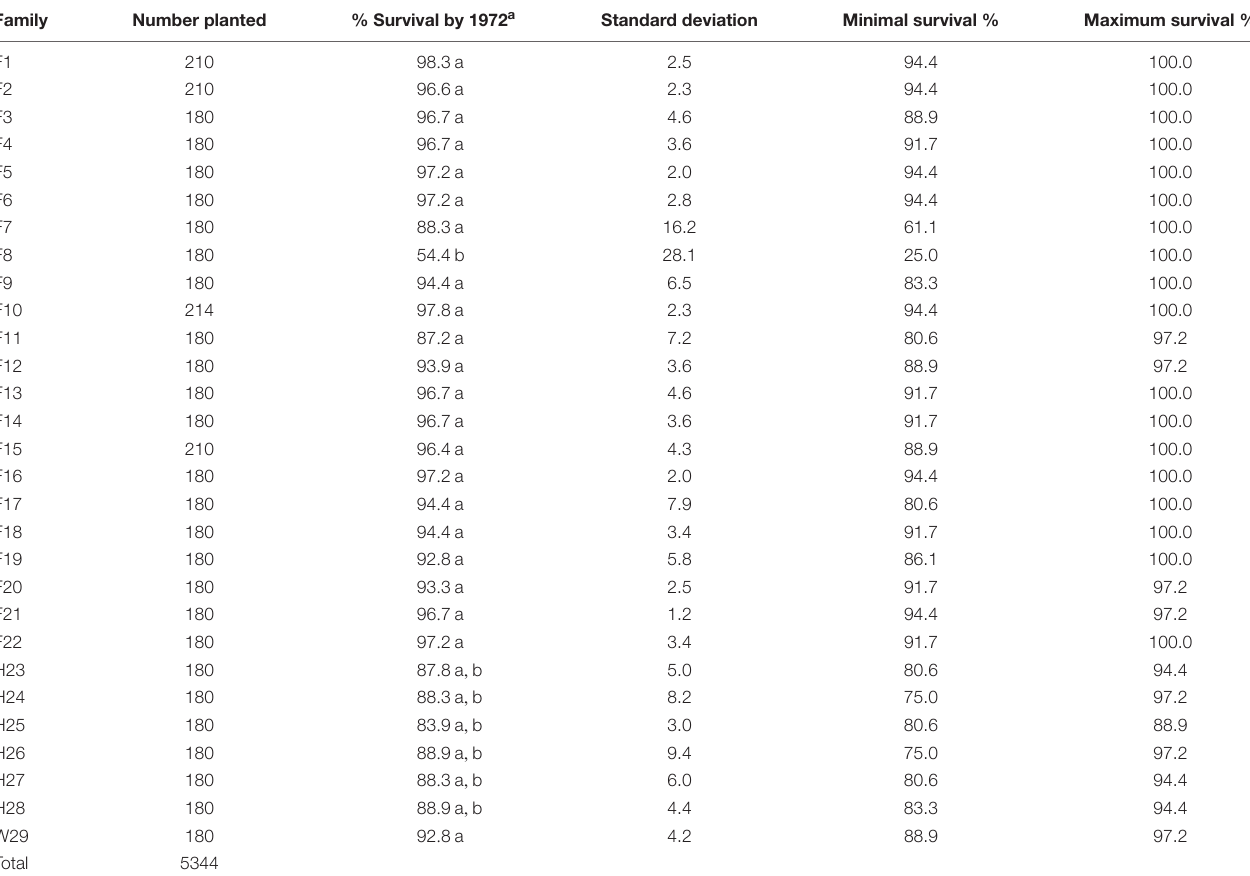
TABLE 2 | Three-year percent survivorship of the 1969 outplanting in Compartment 3 of the Crossett Experimental Forest, measured in 1972 and summarized by family (five replicates, including the five arboretum plots merged with Replicate #5). Family Number planted % Survival by 1972 a Standard deviation Minimal survival % Maximum survival